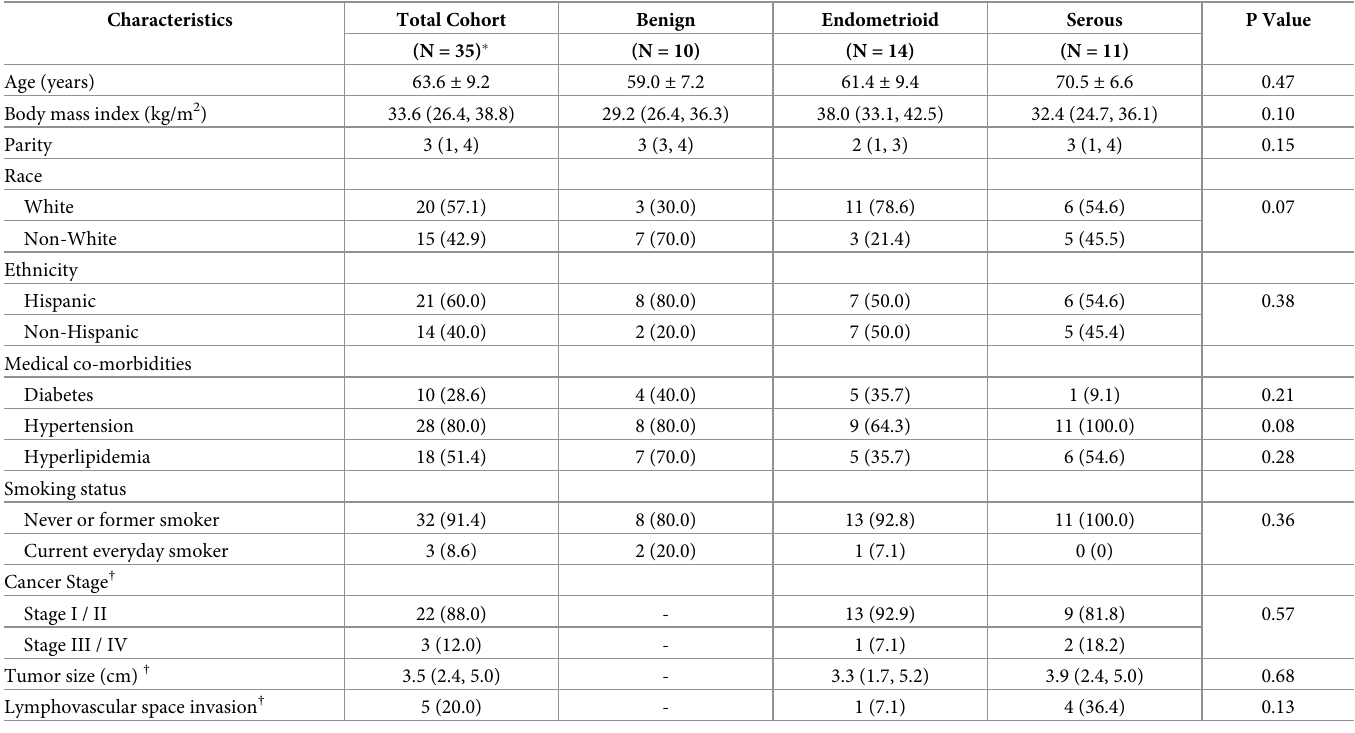
Table 1. Characteristics of subjects (N = 35) included in the study.